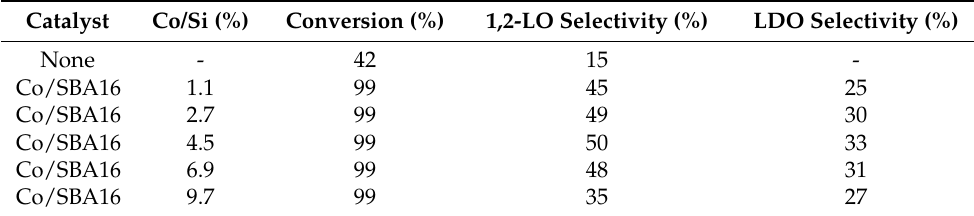
Table 4. Catalytic performances of limonene epoxidation using different cobalt loadings a , reproduced with permission from Ref. [51]. Copyright Elsevier, 2020. Catalyst Co/Si (%) Conversion (%) 1,2-LO Selectivity (%) LDO Selectivity (%)